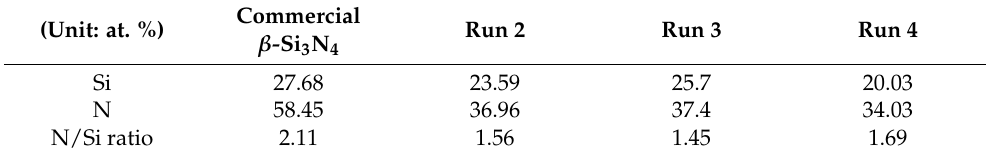
Table 2. Elemental composition of commercial and synthesized Si 3 N 4 powders in Runs 2, 3, and 4. (Unit: at. %) Commercial β- Si 3 N 4